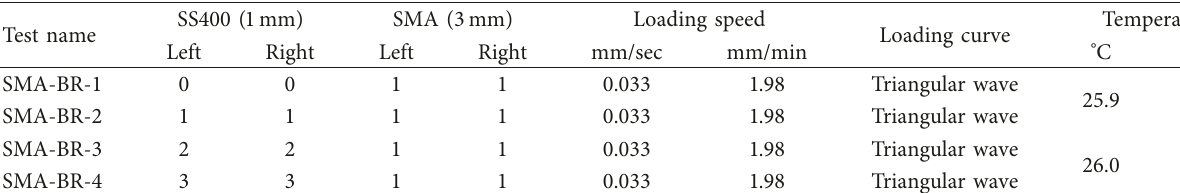
Figure 7: Sample SMA and steel plates. (a) SMA plate. (b) Steel plate. Table 1: Bracing model cases for the experimental tests.